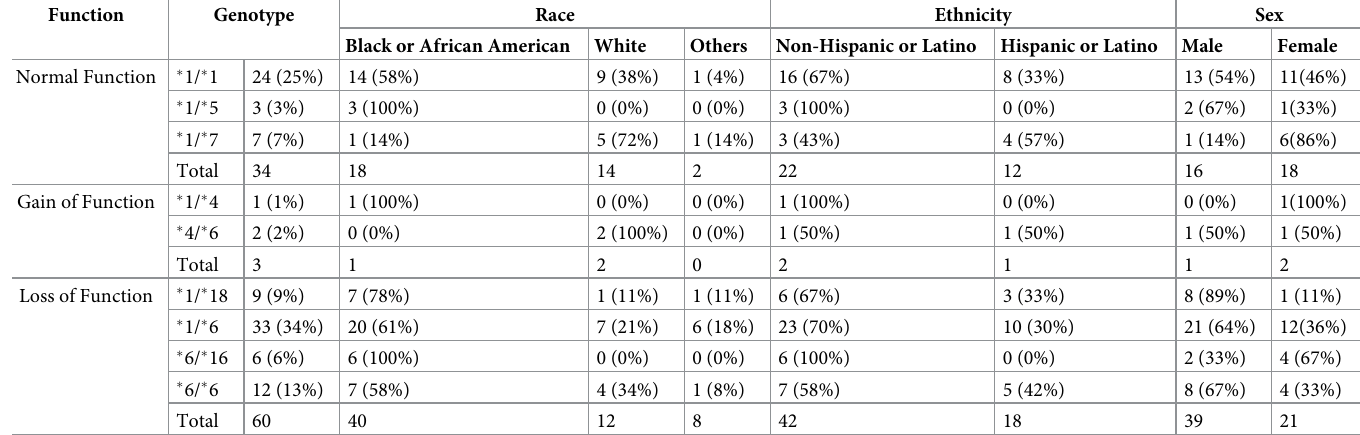
Table 5. Distribution of participants with respect to genotype, genotype by race, genotype by ethnicity and genotype by sex. Column percentages of genotypes are calculated with reference to the total number (n = 97) of participants. Row percentages are calculated with reference to the number of participants with each genotype.